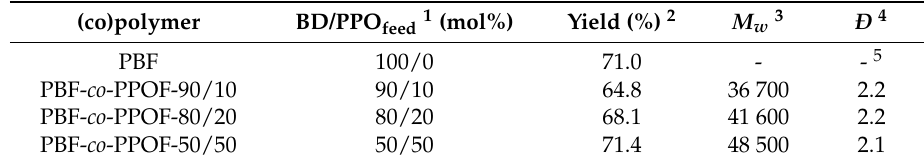
Scheme 1. Synthesis of PBF- co -PPOF co-polymers. Table 1. Molecular characteristics of PBF and PBF- co -PPOF co -polymers.